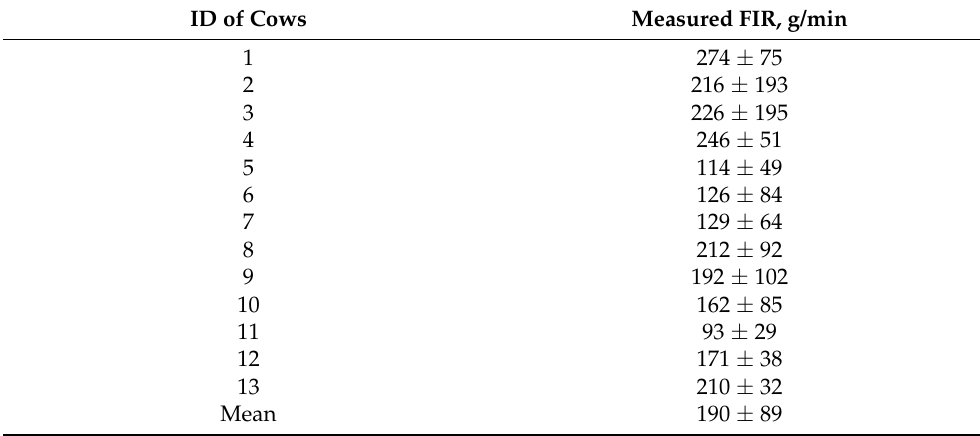
Table 2. Measured feed intake rates (FIR, grams per minute) of experimental cows. ID of Cows Measured FIR,